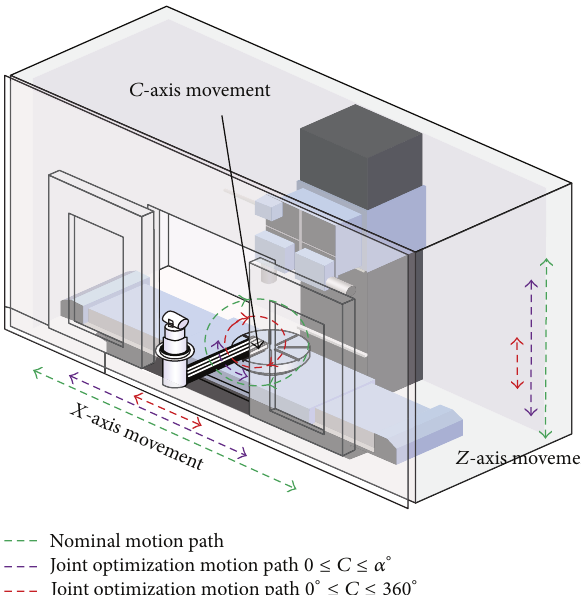
Figure 11: Range of movement in relation to the characterization method.